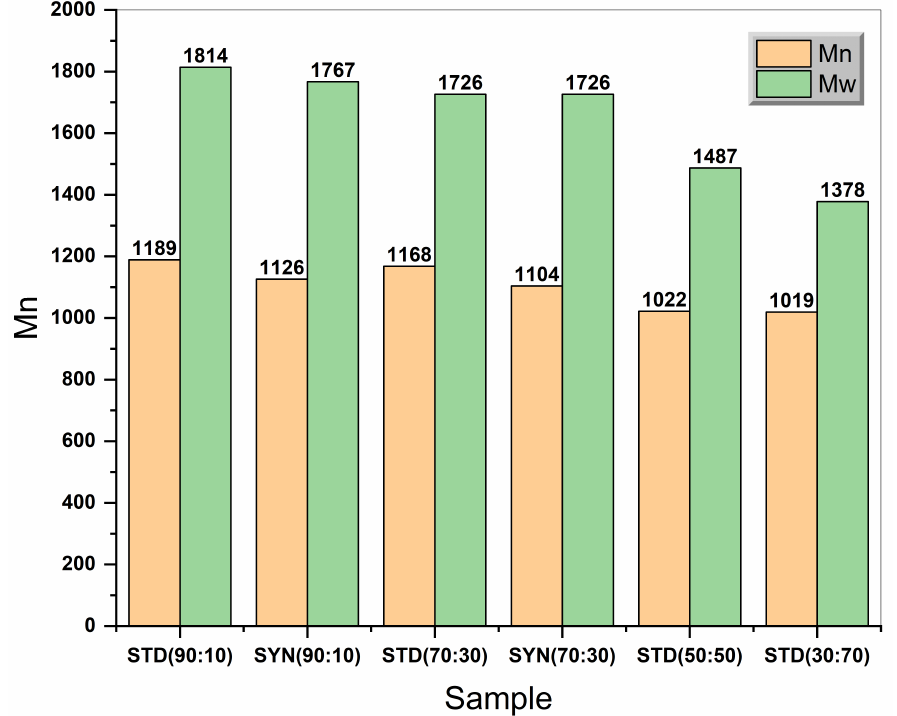
Figure 8. Representation of M n and M w of each